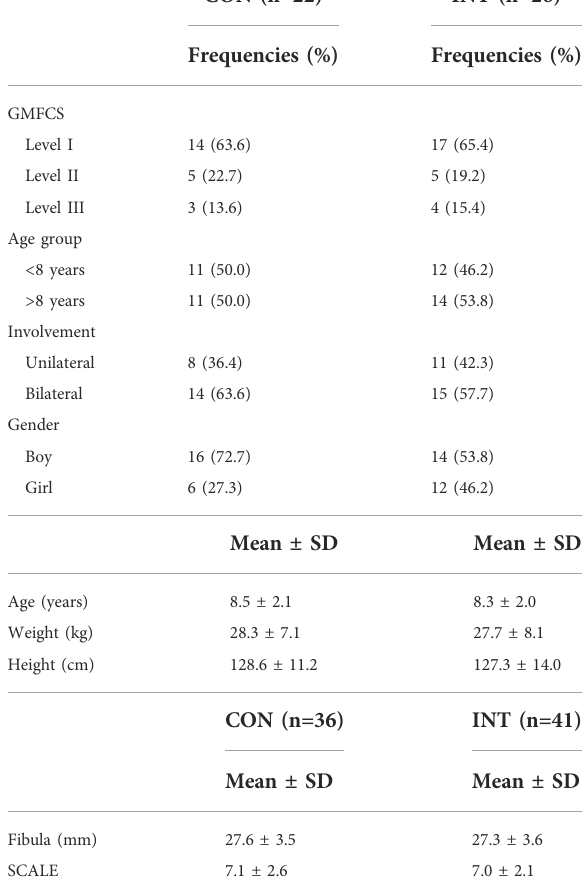
TABLE 1 Descriptive statistics of patient characteristics for all participants (or legs) included in the primary